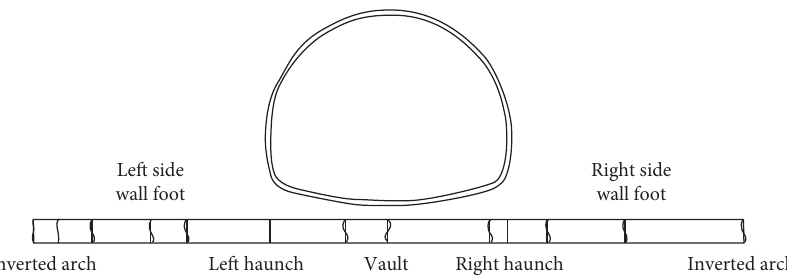
Figure 11: Distribution of lining cracks of the reinforced